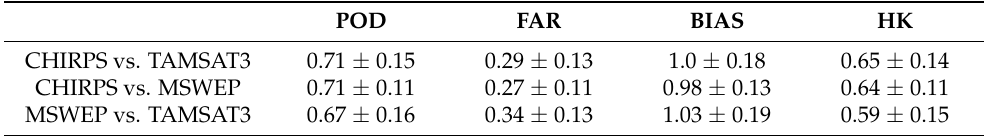
Table 4. Same as in Table 3 but for